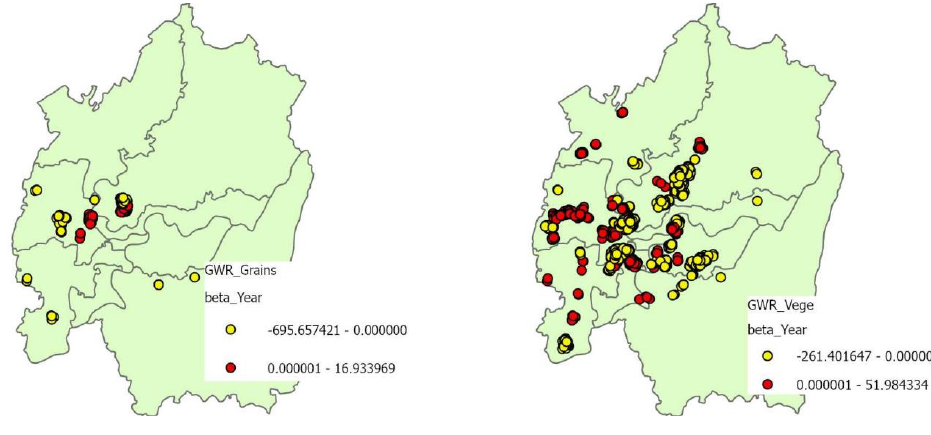
Figure 12. House price coeffects with the accessibility values of vegetables, fruit, seafood, meat, and milk in Chongqing.